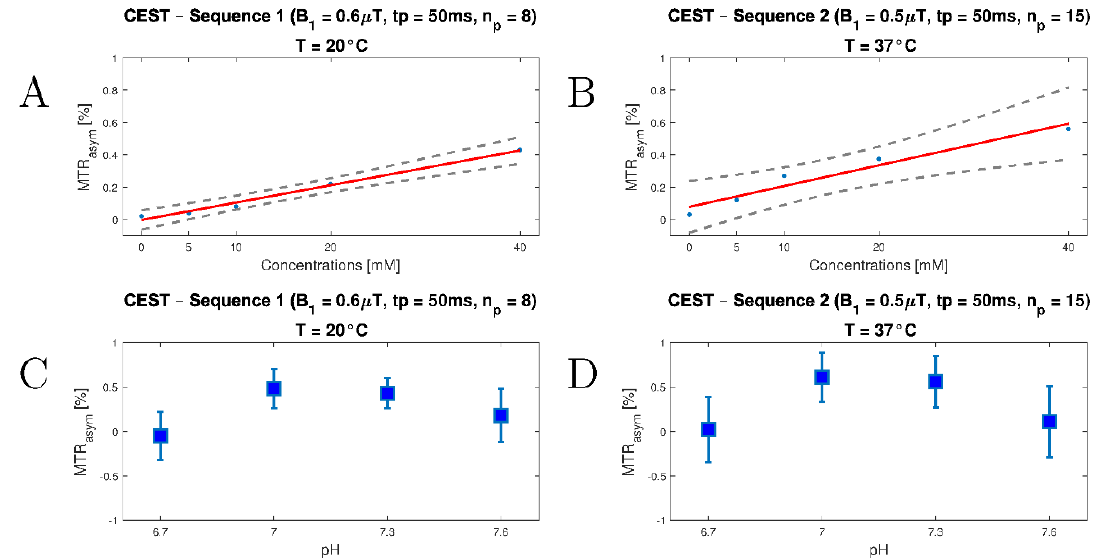
Figure 3. Plots to visualize MTR asym values (MTR asym ) as a function of lactate concentration and pH value for two CEST sequences (i.e., CEST-Sequence 1 for future in situ use with B1 = 0.6 µ T, tp = 50 ms, and np = 8; CEST-Sequence 2 for future in vivo use with B1 = 0.5 µ T, tp = 50 ms, and np = 15) at ( A , C ) room temperature and ( B , D ) 37 ◦ C. In addition to MTR asym (blue dots), linear regression (red continuous line) and 95% confidence intervals (grey dashed lines) are plotted for concentration dependence. For the pH dependence, the values are given as error plots with mean and standard deviation. Z-spectra were corrected using WASSR correction, and temperature was stabilized at 37 ◦ C using a 450 mL water bath.